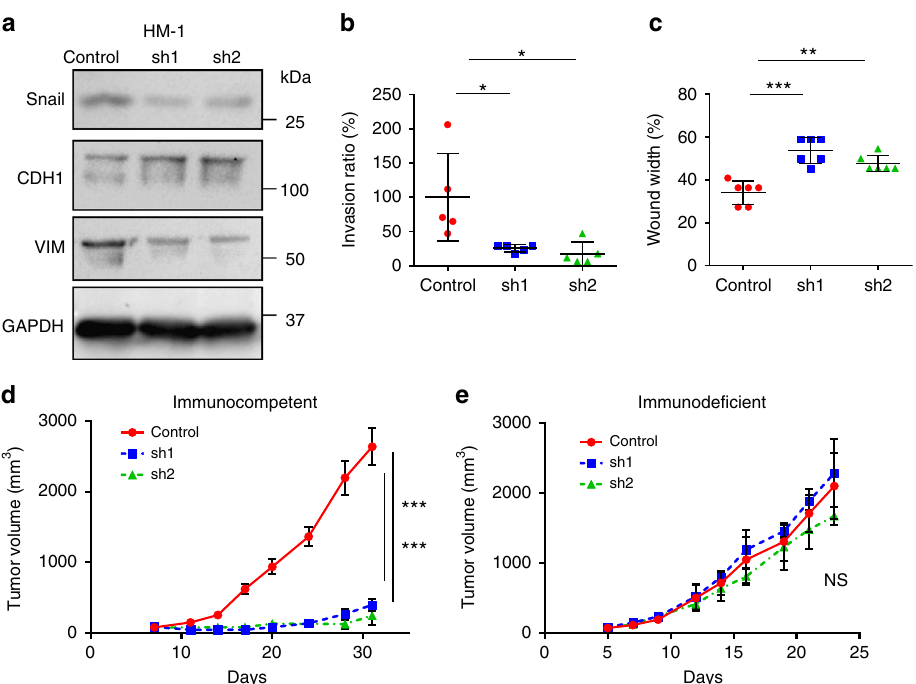
Fig. 2 Snail suppresses tumor progression and is associated with tumor immunity. a Western blot of HM-1-control and HM-1-shSnail cells. CDH1: E-Cadherin, VIM vimentin. b Invasion of HM-1-control and HM-1-shSnail cells; n = 5. c Wound healing of HM-1-control and HM-1-shSnail cells. Data represent the percentage of wound width (24 h) relative to that at 0 h; n = 6. d Growth curves of HM-1-control and HM-1-shSnail subcutaneous tumors in immunocompetent mice. P -values represent signi fi cance between two groups at day 31; n = 6. e Growth curves of HM-1-control and HM-1-shSnail subcutaneous tumors from immunode fi cient nude mice; n = 6; NS no signi fi cant difference between two groups at day 23. * P < 0.05, ** P < 0.01, and *** P < 0.001 (one-way ANOVA with Tukey ’ s multiple comparisons test in b – e ). Averaged data are presented as the mean ± P = 0.031; Supplementary Table 1). These results suggest that